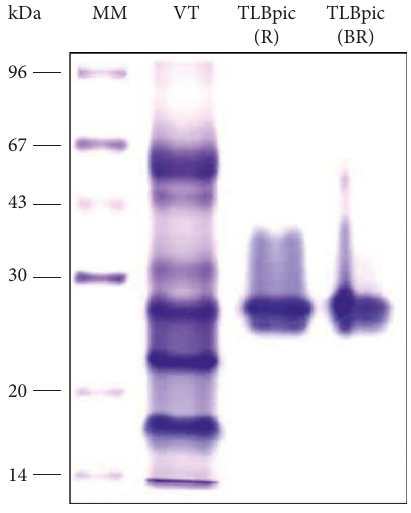
Figure 2: Electrophoresis analysis.